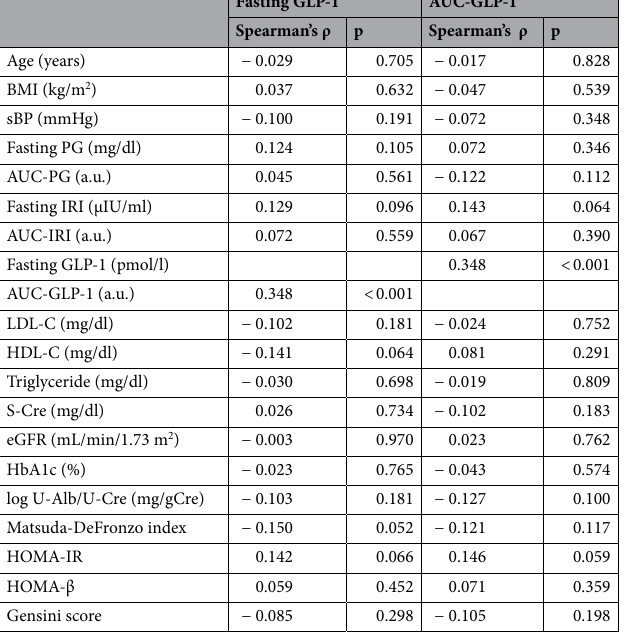
Table 2. Correlation coefficients for fasting GLP-1 and AUC-GLP-1. sBP: systolic blood pressure; BMI: body mass index; PG: plasma glucose; IRI: immunoreactive insulin; LDL-C: LDL cholesterol; HDL-C: HDL cholesterol; S-Cre: serum creatinine; eGFR: estimated glomerular filtration rate; HbA1c: hemoglobin A1c; U-Alb/U-Cre: ratio of urinary albumin to urinary creatinine.